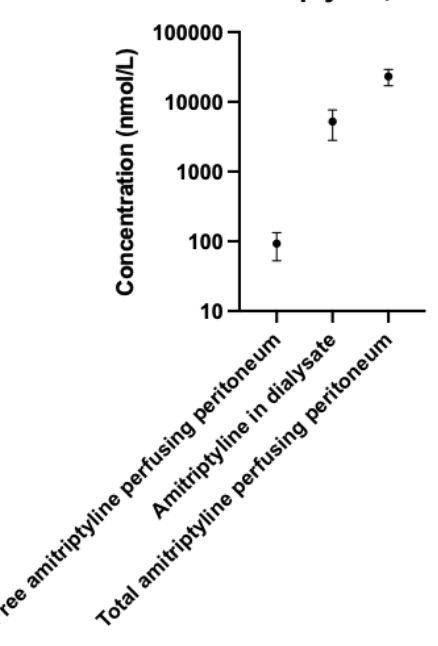
Figure 3. concentrations of amitriptyline in dialysate against free and total amitriptyline perfusing the peritoneal membrane. the peritoneal